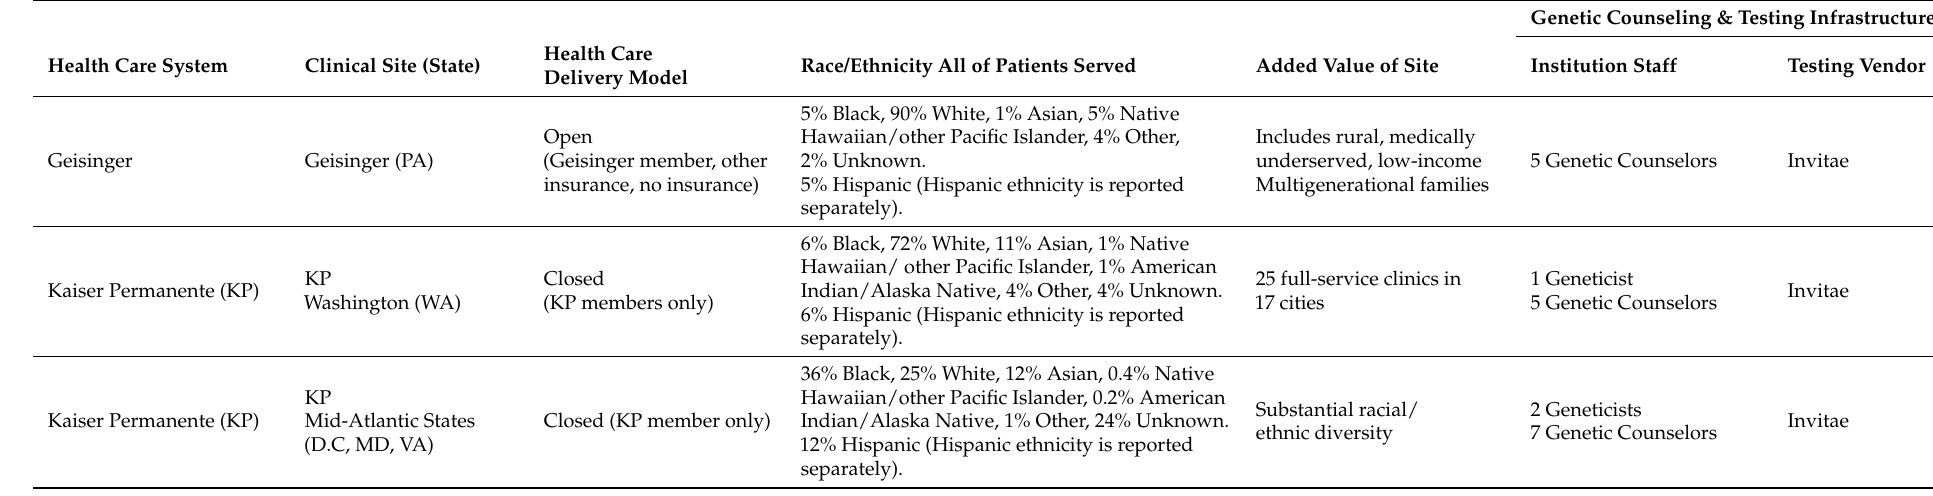
Table 1. Overview of participating healthcare systems and genetic screening programs.